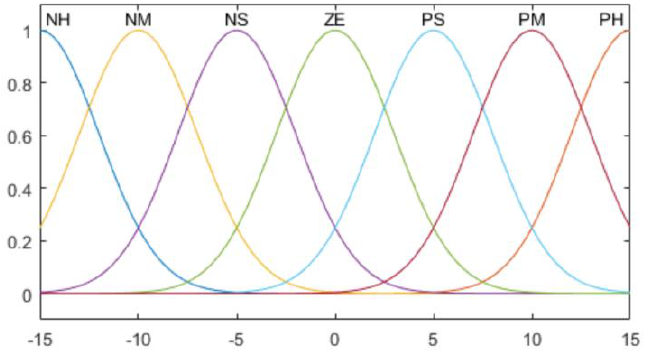
Figure 18. Surface of fuzzy controller. 6. Robot Hand Control System The system is controlled by a PC and three microcontroller units (MCUs), as shown in Figure 19. The PC performs kinematics operation through a MATLAB graphic user interface and forwards the target position derived through inverse kinematics to an MCU. The MCU proceeds to control through the transmitted information and performs a feedback of the current information to the PC. The robot used herein has a gripper-type robot hand attached to a five-degree-of-freedom manipulator comprising five DC motors. Figure 19. Control system configuration.